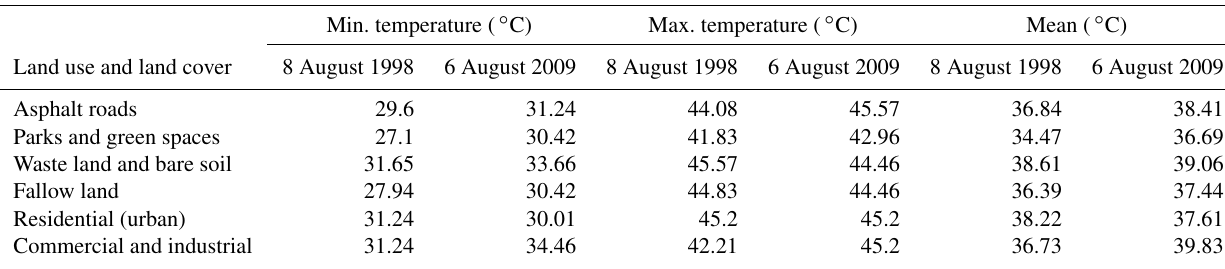
Figure 9. Linear relationship between ground-based measured temperature and land surface temperature (LST) of Landsat TM sensor: (a) 8 August 1998, (b) 6 August 2009. Table 7. Land surface temperature of different land use categories of Yazd city.